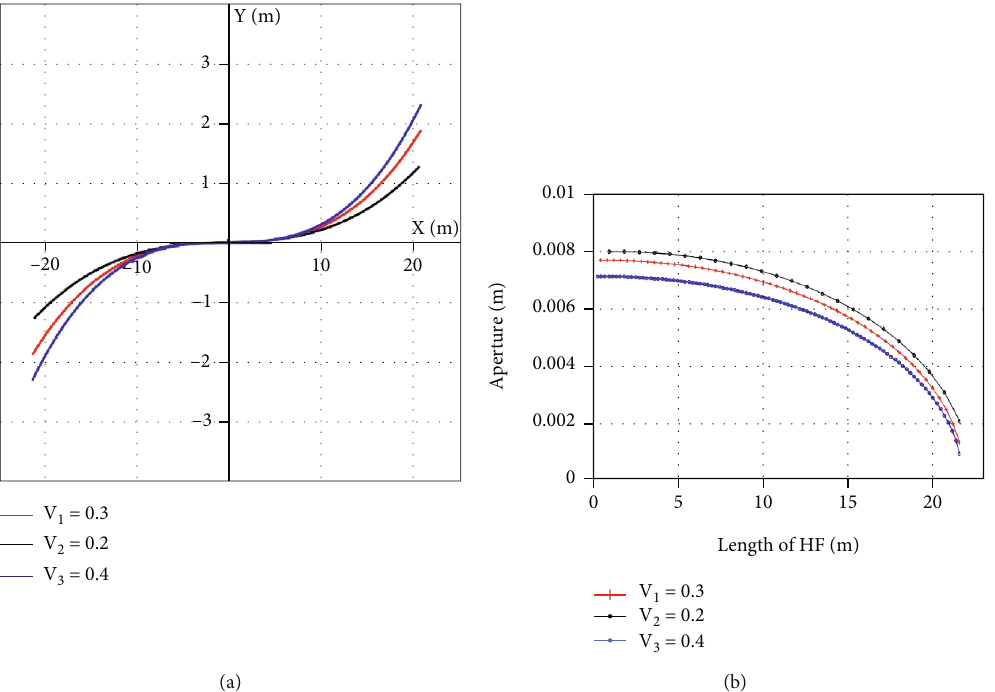
Figure 12: Simulation results with di ff erent Poisson ’ s ratios: (a) fracture morphology; (b) fracture